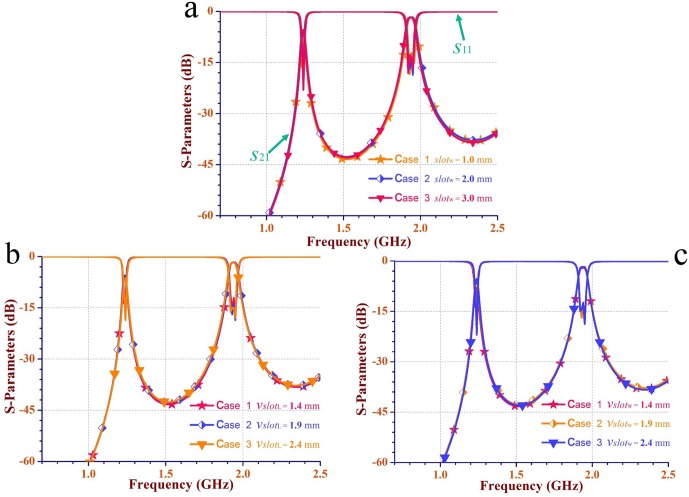
The sensitivity analysis for the SIW filter in Fig 7.(a) The scattering parameters (S11 and S21) of the interference slot with different widths (slotw) in each cavity. (b-c) The scattering parameters of a connected slot with different lengths (VslotL) and widths (Vslotw) in each cavity, respectively.